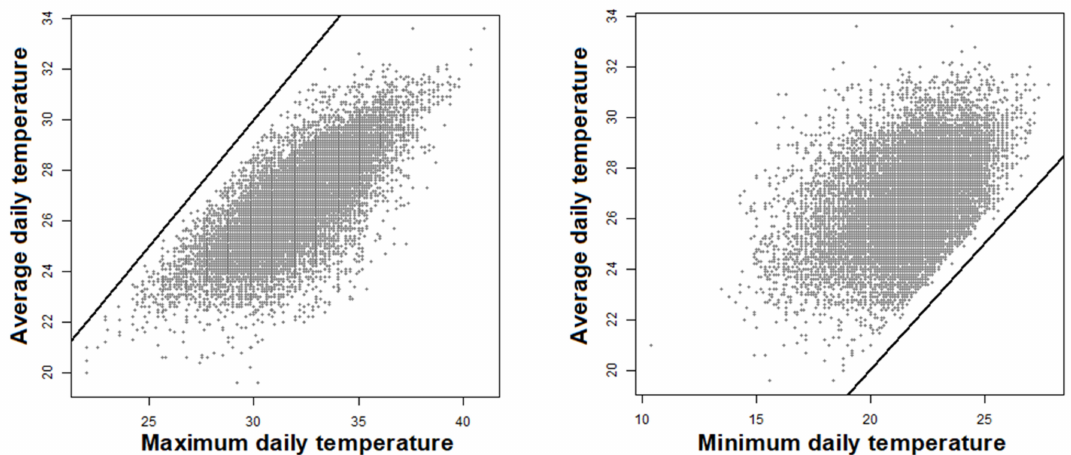
Figure 13. Results of the first consistency test between variables. The figure on the left shows that no average temperature value was higher than the daily maximum temperature, and the figure on the right shows that no average temperature value was lower than the daily minimum temperature. If any of the conditions failed due to suspicious data, these values would be identified as red dots to the left or to the right of the diagonal lines in the